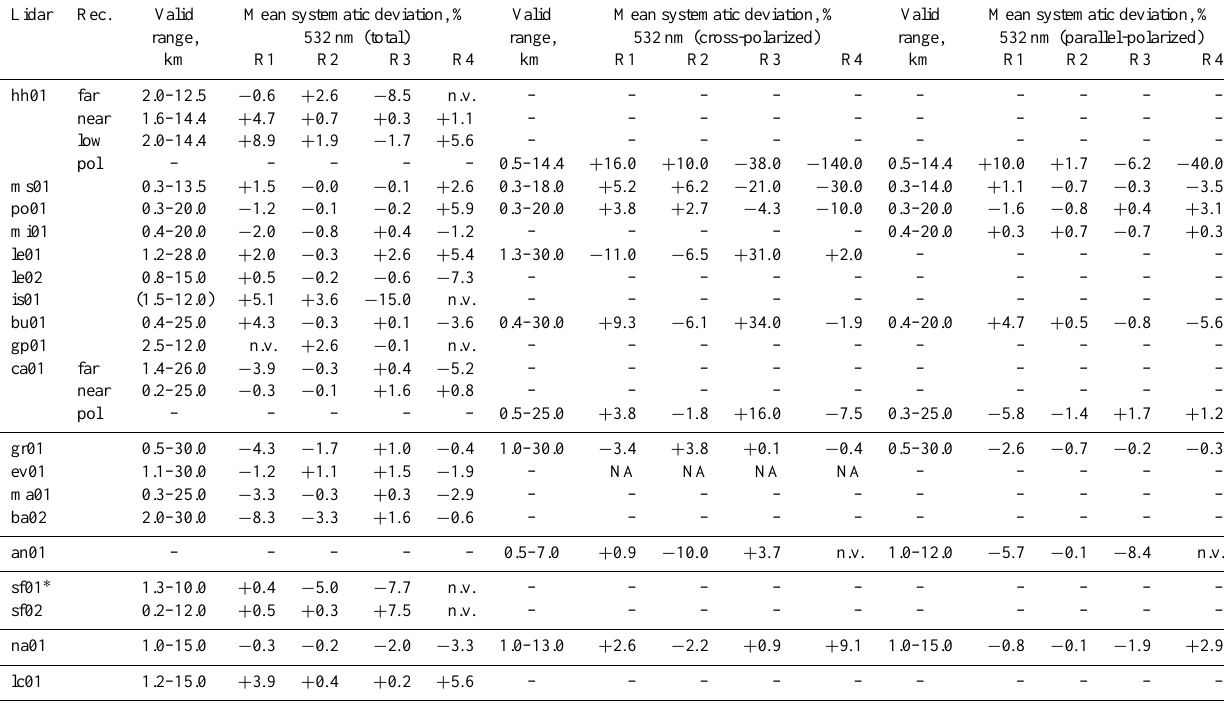
Table 4. Valid range and mean systematic deviation of signals at 532nm (total), 532nm (cross-polarized), and 532nm (parallel-polarized) in four height ranges: R1 (lowest valid range–2.5km), R2 (2.5–6km), R3 (6–12km), and R4 (12km–highest valid range). n.v. denotes not valid. NA denotes not available. Rec. denotes receiver